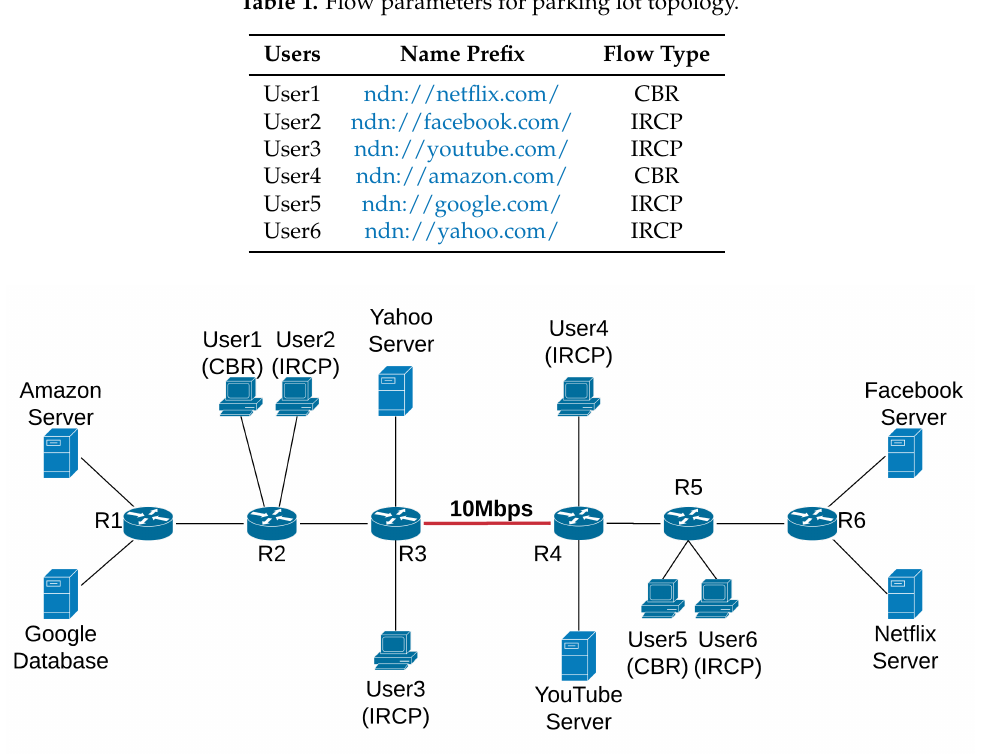
Figure 6. Parking lot topology with 10 Mbps bottleneck link.